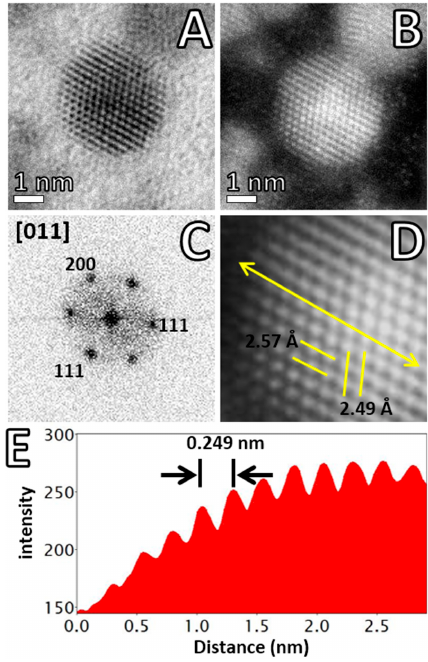
Figure 4. Atomic resolution Cs-STEM imaging. ( A ) BF-STEM imaging. ( B ) HAADF-STEM imaging. ( C ) FFT pattern. ( D ) Detail of palladium nanoparticle with interplanar distances. ( E ) Intensity profile of arrow in ( D ). Imaging with JEM ARM-200F (JEOL), operated at an accelerating voltage of 80 kV in STEM mode.